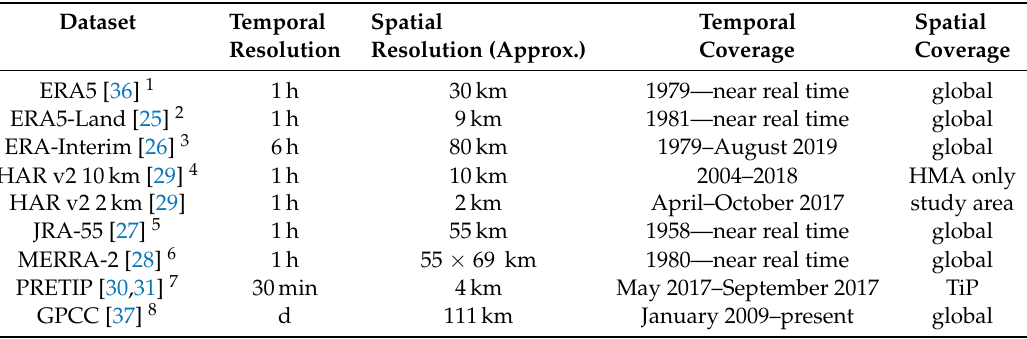
Table 1. Overview